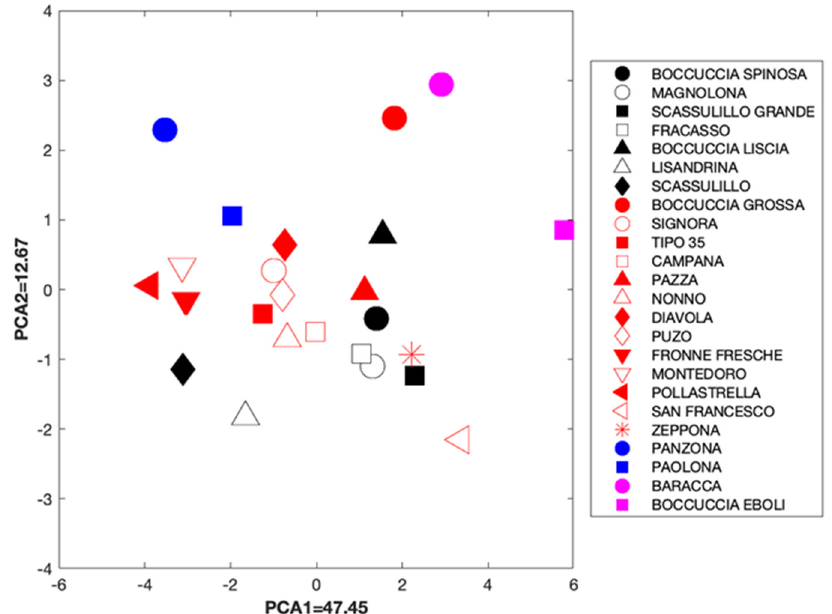
Figure 2. Varieties plotted using the first two PCA components and considering all the available (standardized) (standardized) data.